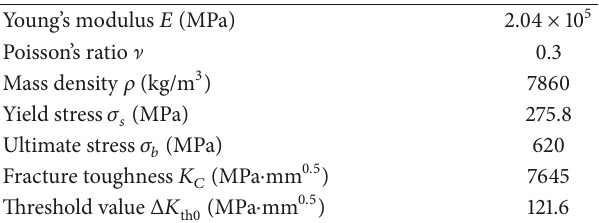
Table 1: Material properties of 304SS.